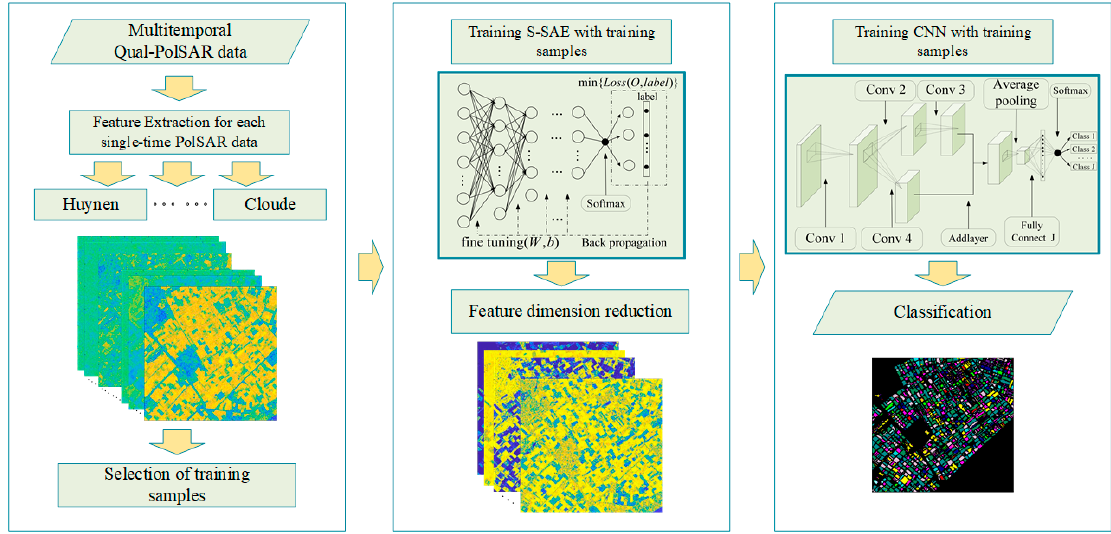
Figure 1. Flow chart of the proposed method. CNN: convolutional neural network, PolSAR: Figure1. Flowchartoftheproposedmethod. CNN:convolutionalneuralnetwork, PolSAR:polarimetric polarimetric synthetic aperture radar, S-SAE: stacked sparse auto-encoder. synthetic aperture radar, S-SAE: stacked sparse